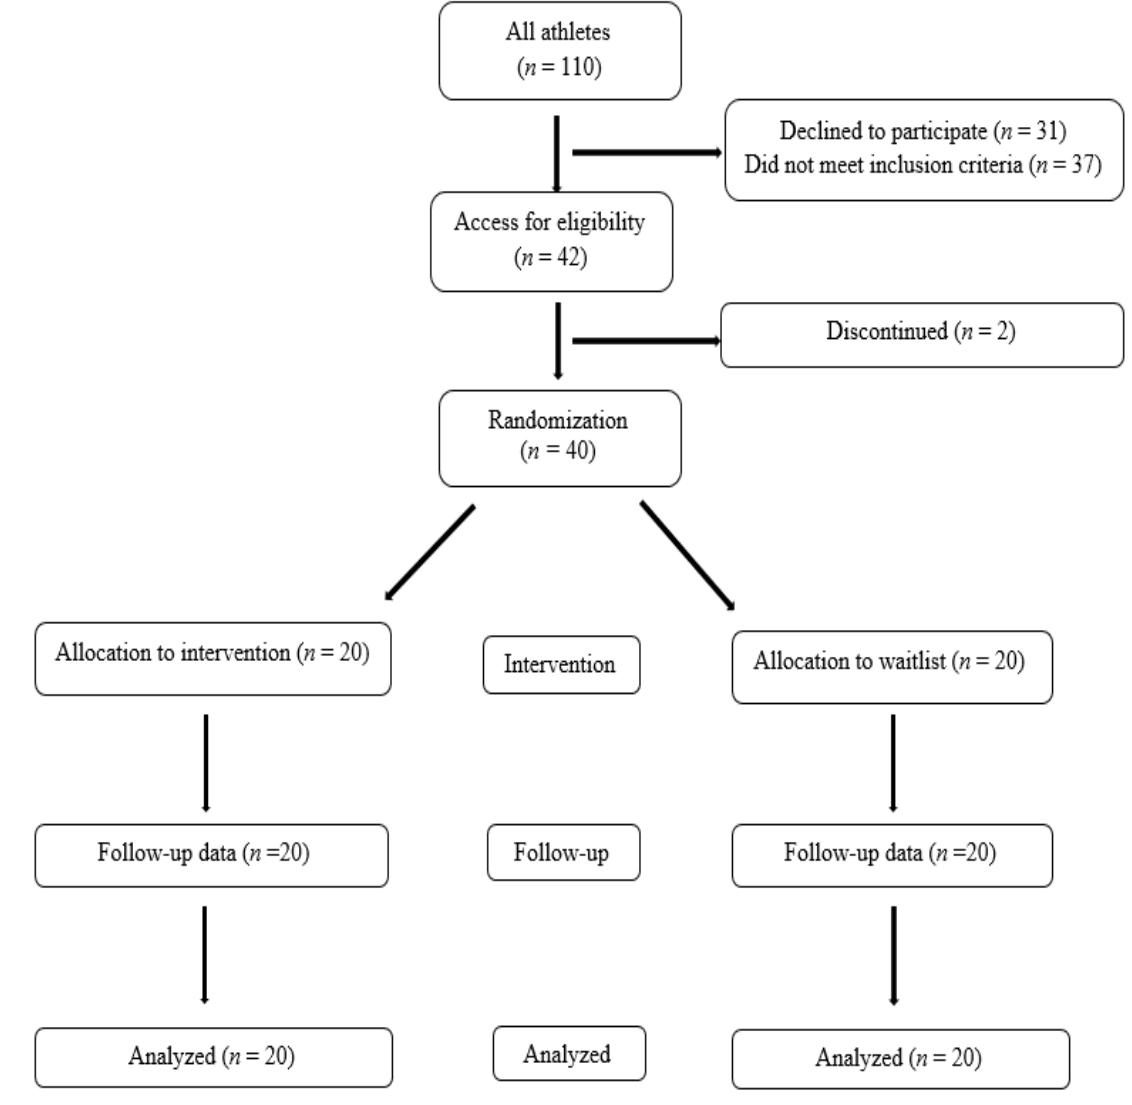
Figure 1. Consort flow diagram.